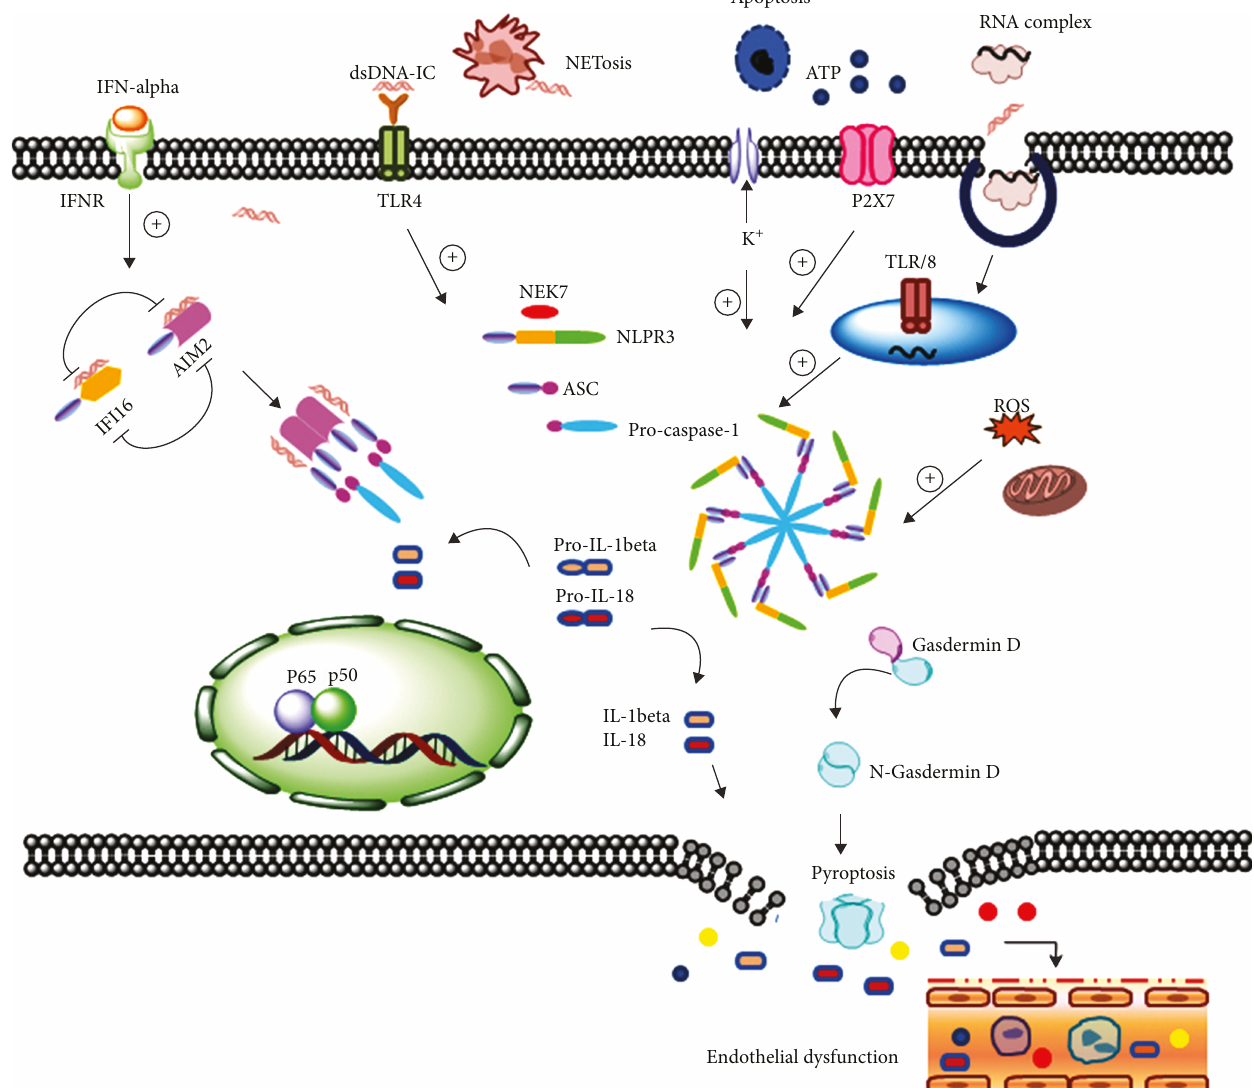
Figure 1: Schematic illustration of the role of in fl ammasomes in lupus nephritis. ATP released from dead cells activates P2X7 on the cell membrane, inducing the K + e ffl ux and NLRP3 in fl ammasome assembly. The assembly of NLRP3 in fl ammasomes and maturation of caspase-1 caused the cleavage of pro-IL-18 and pro-IL-1 β , as well as the release of the N-terminal gasdermin D to induce pyroptosis. The neutrophil extracellular trap releases a large amount of dsDNA and other cellular components and induces the formation of a dsDNA- containing immune complex, which promotes the activation of NLRP3 in fl ammasomes via TLRs. The endogenous RNA-containing complex can also activate NLRP3 in fl ammasomes through the endosome-located TLR7/8 signaling pathway. AIM2 and another IFI family member IFI16 can sense/recognize dsDNA, leading to the activation of caspase-1 and maturation of IL-18 and IL-1 β . The signature cytokine of lupus, IFN- α , binds to IFN receptors on the cell surface, which regulate the expression and maximum activity of AIM2 in fl ammasomes. Released IL-1 β , IL-18, and other in fl ammatory mediators resulted in endothelial leakage, immune cell in fi ltration, and fi nally tissue in fl ammation and functional deterioration of the